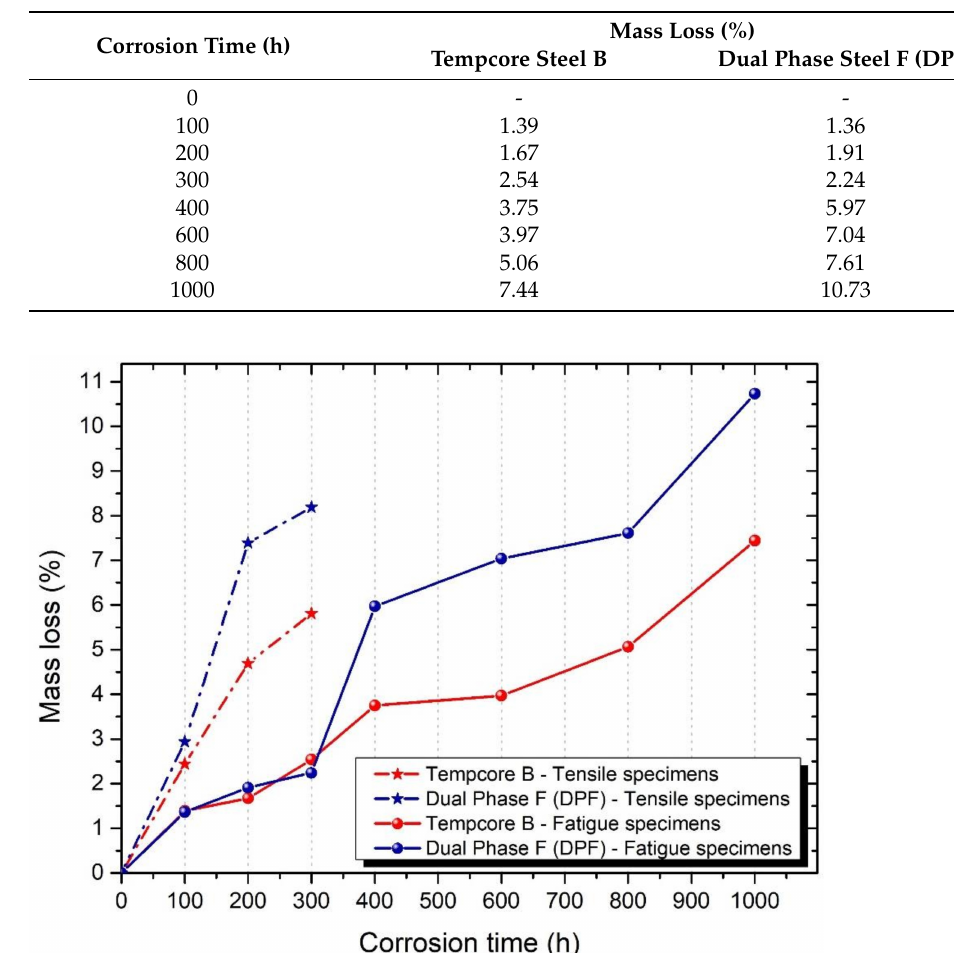
Table 4. Percentage mass loss vs. corrosion time for fatigue specimens (short specimens).